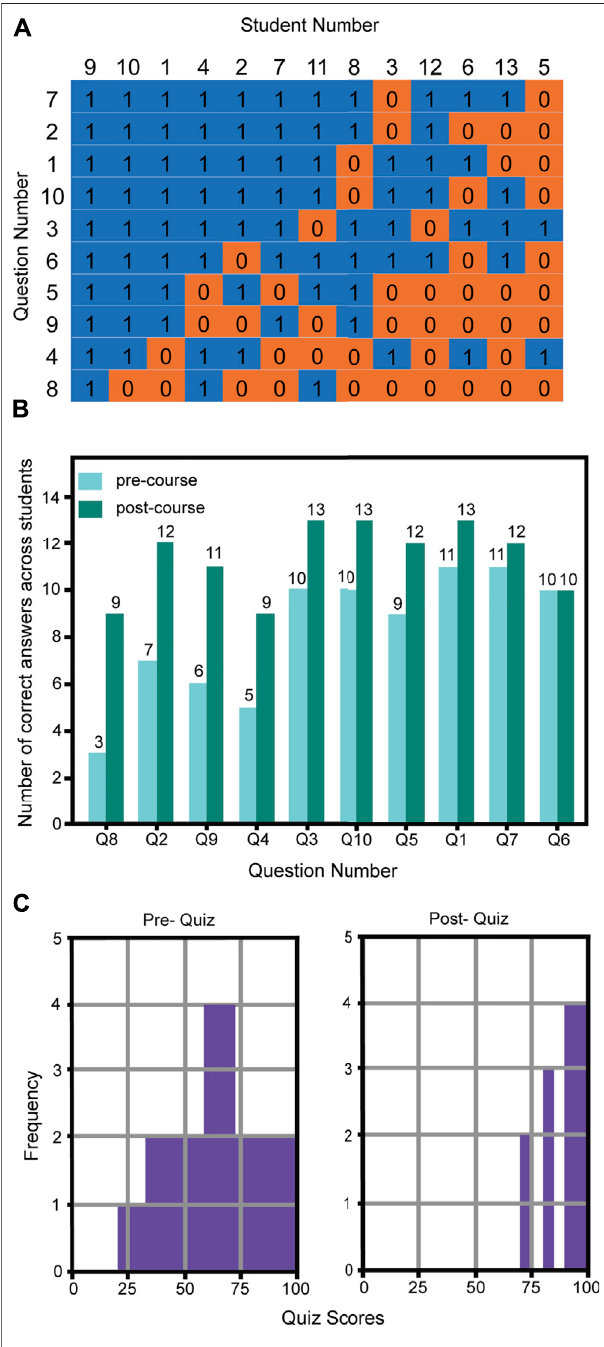
FIGURE 5 | Pre- and post-course knowledge survey of 13 students in NCState ’ sBiotechnology(BIT)477/577Fall2020course. (A) Pre-quizscores arranged by students and questions to highlight diversity in pre-knowledge. Responses are sorted to visually show pattern and clustering of correct and incorrect responses. 1 (cid:1) correct, 0 (cid:1) incorrect responses, n (cid:1) 13 students. (B) Correct and incorrect pre- and post-course quiz